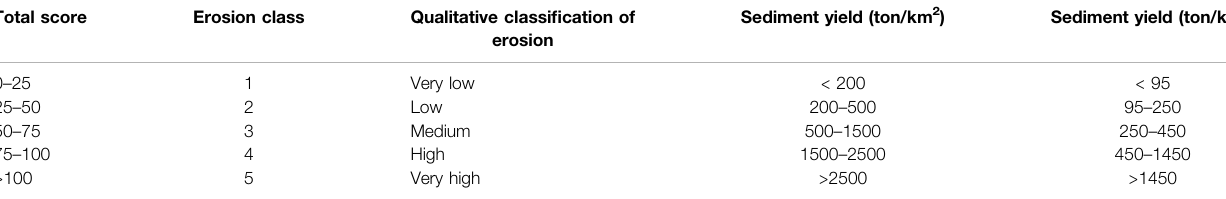
TABLE 1 | Determining the annual sediment yield and erosion class by using the MPSIAC model.